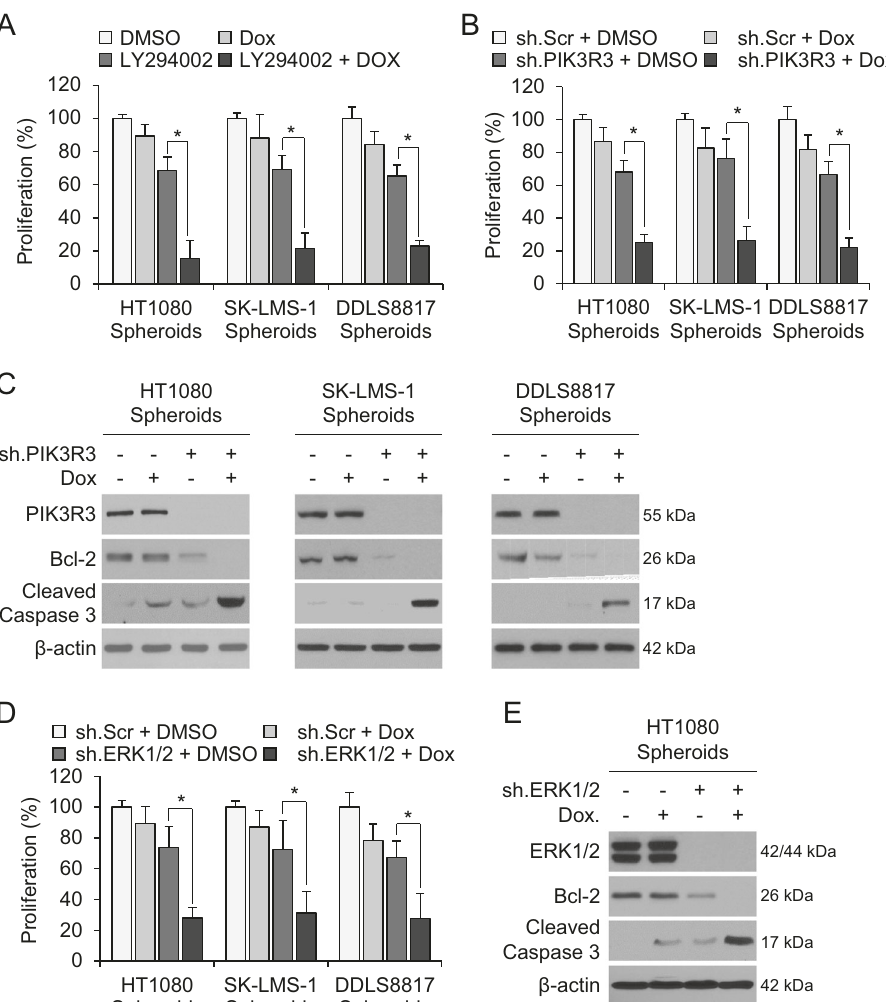
Fig. 5 PI3K inhibition reverses chemotherapy resistance. All cells cultured as spheroids. Proliferation following treatment with combinations of ( A ) LY294002, doxorubicin, or DMSO ( A ), and doxorubicin, sh.PIK3R3, or sh.Scr ( B ). C Western blot for PIK3R3, Bcl-2, and cleaved caspase 3 following treatment with the same agents as in ( B ). D Proliferation following treatment with doxorubicin, sh.ERK1/2, or sh.Scr. E Western blot for PIK3R3, Bcl-2, and cleaved caspase 3 following treatment with same agents as in ( D ). β -actin is the loading control. * p < 0.05 compared to